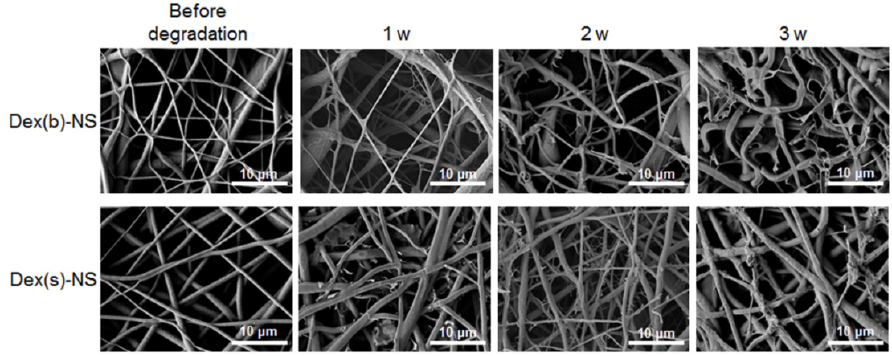
Figure 8. SEM images before and after in vivo biodegradation of NS, Dex(b) ‐ NS, and Dex(s) ‐ NS after 1–3 weeks (×3000 magnification).